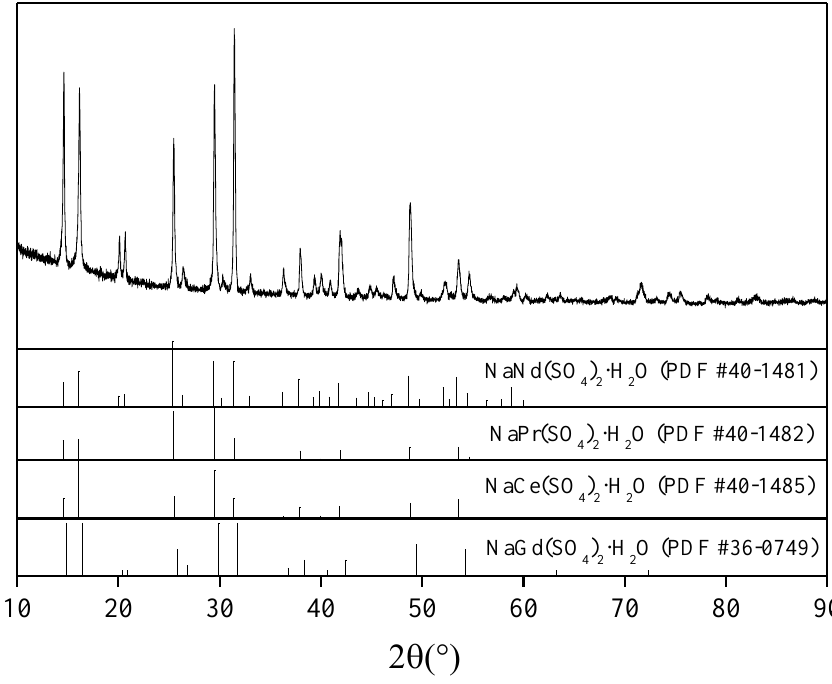
Figure 6. XRD pattern of mixed double sulfates precipitation.